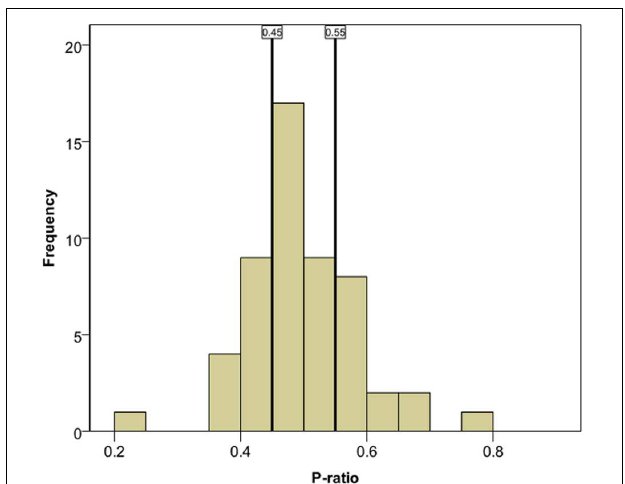
FIGURE 2 | Distribution of p -ratios for the AHPP. Vertical lines show the cutoff points for the categorization of a score as extreme or moderate. P -ratio scores to the left of the 0.45 line or to the right of the 0.55 line are ‘extreme’ and are classified as novelty and familiarity preferences respectively.